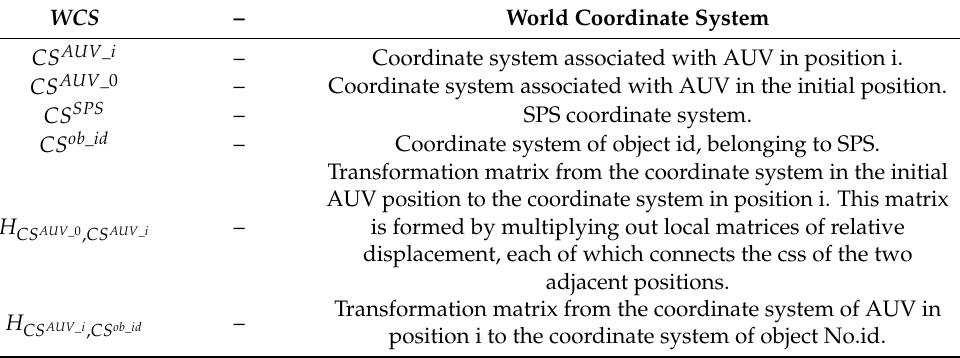
Table 1. Coordinate systems and transformations